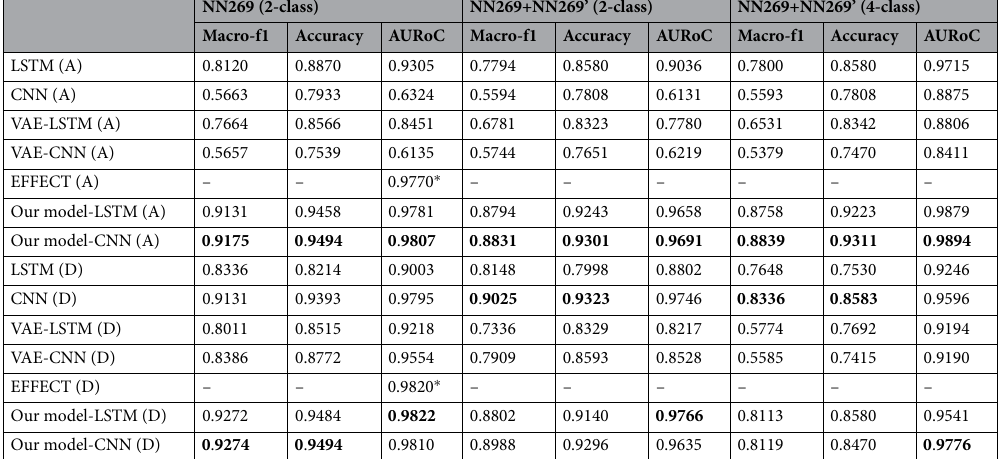
Table 8. Comparison between our model and baselines on the gene classification with the mutation detection task. *The best result from the corresponding paper. 2-class refers to AP , AN for acceptor, and DP , DN for donor. 4-class refers to AP , AN , AP acceptor and donor. The best results are marked in